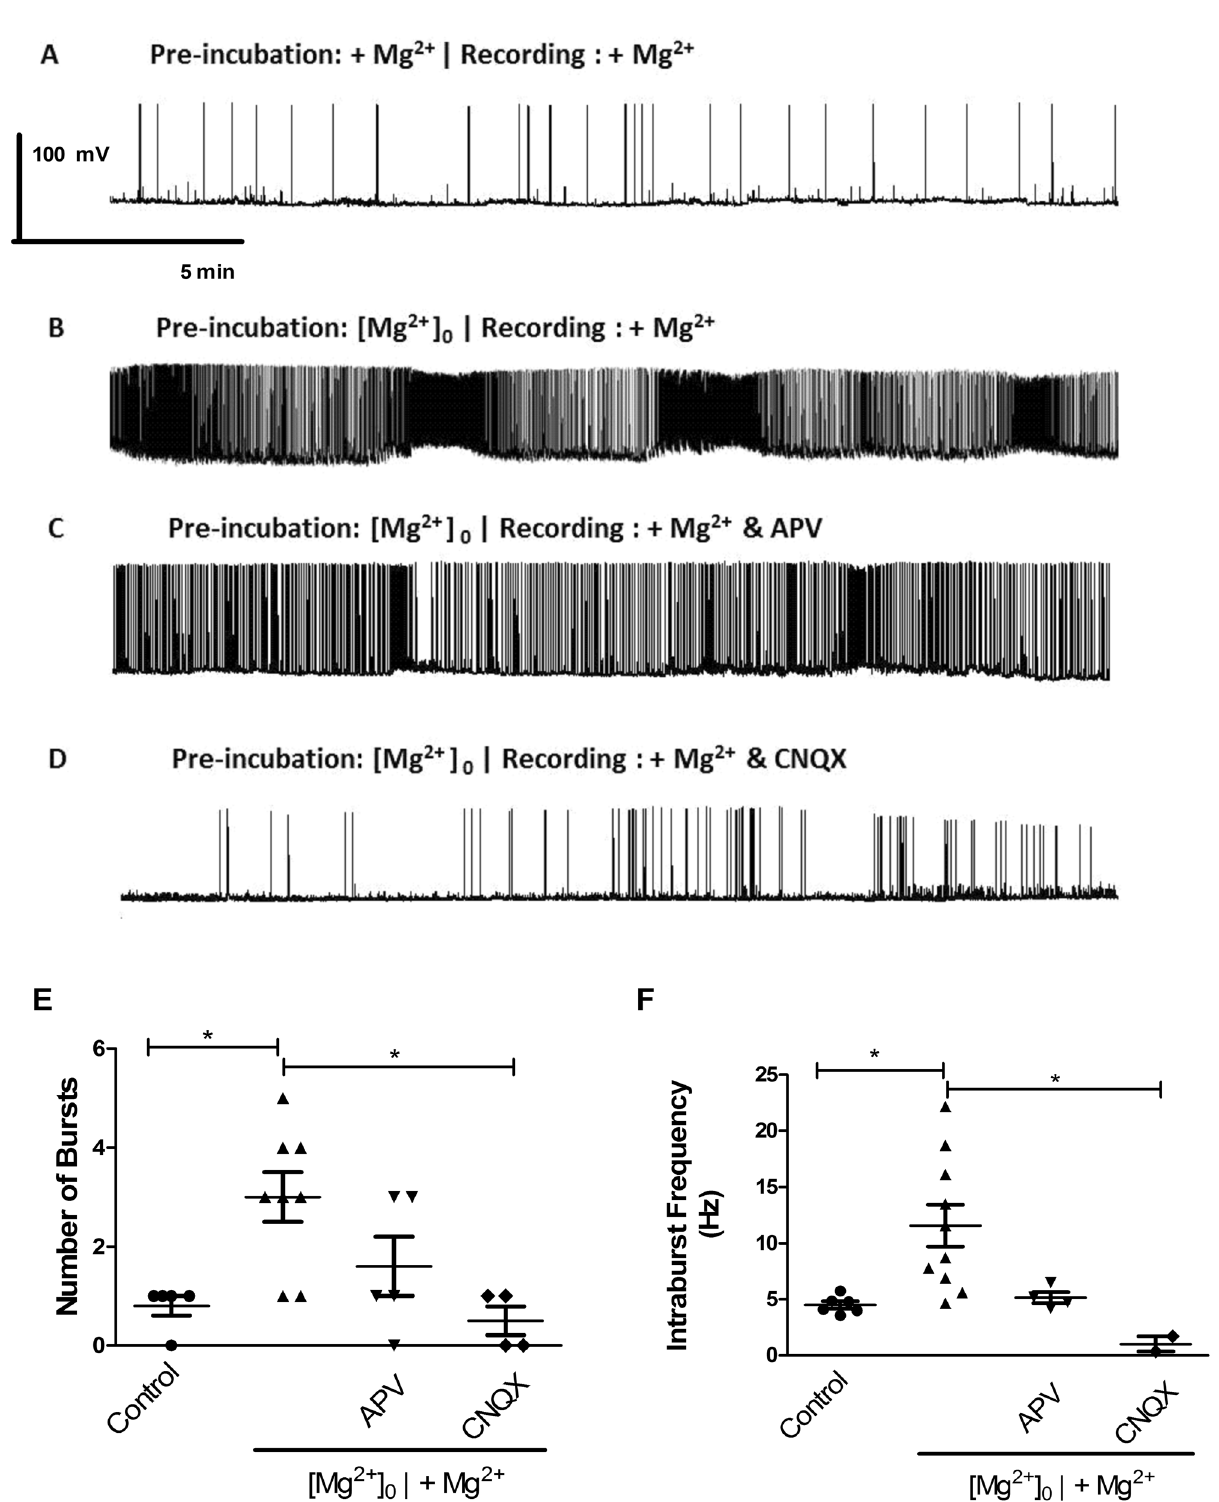
Figure 6. The rhythmic bursting activity induced by incubation in [Mg 2+ ] 0 medium depends on the activity of ionotropic glutamate receptors. ( A–D ) Representative 25 min recordings after incubation in control salt solution ( A ), or after 15 min of stimulation in [Mg 2+ ] 0 medium mimicking SE ( B–D ). Recordings were performed in control salt solution, in the absence ( B ) or in the presence of APV (50 µM) ( C ) or CNQX (20 µM) ( D ). The average number of bursts during the 25 min recording is plotted in panel ( E ). Panel ( F ) shows the mean frequency of intraburst events. Burst analysis was performed using the Poisson Surprise method. The results are the mean ± SEM of 10 cells from at least 3 independent preparations. Statistical analysis was performed by one- way ANOVA followed by the Bonferroni test (* p <